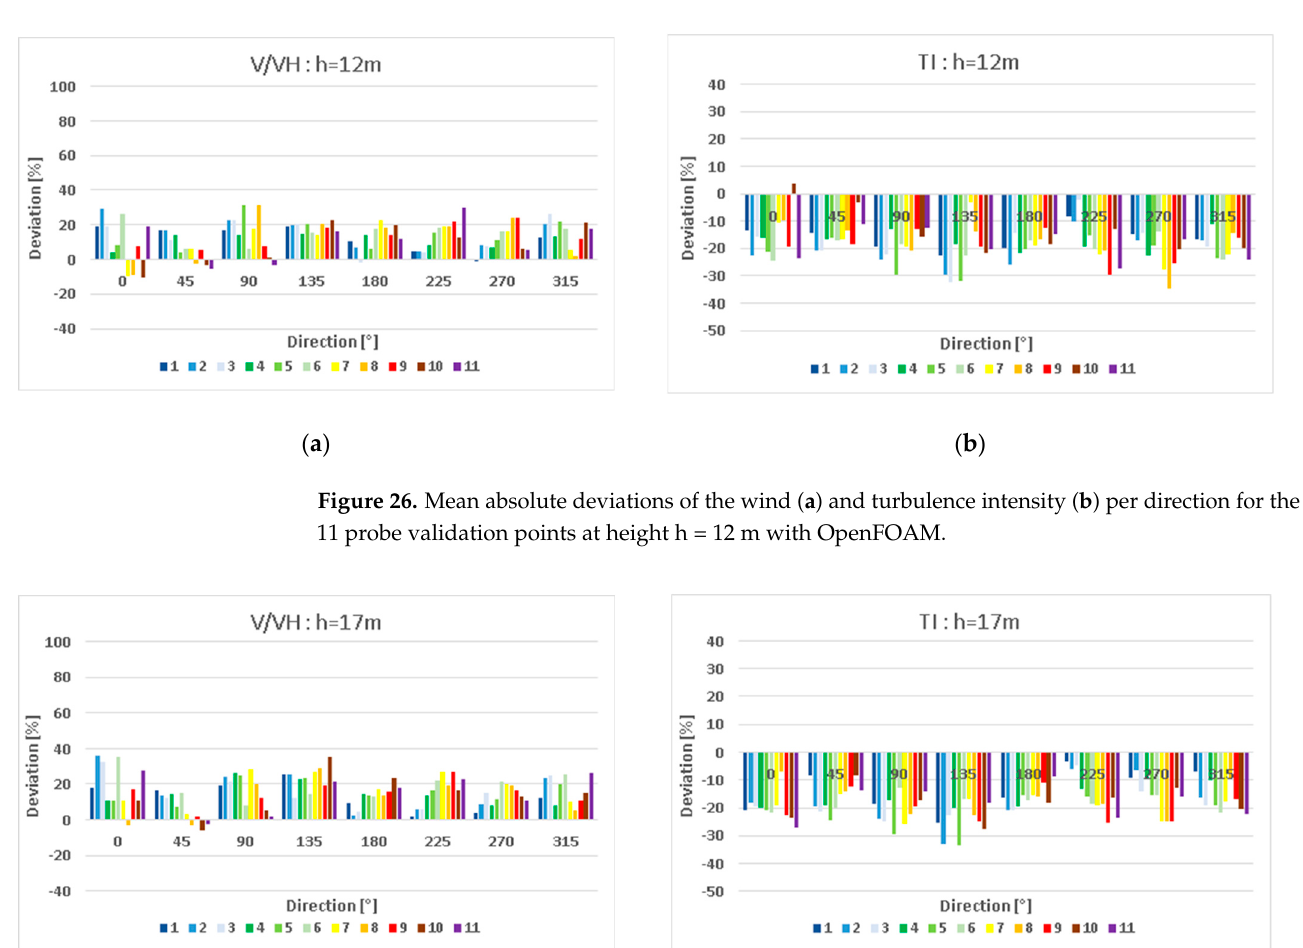
the 11 probe validation points at height h = 9 m with OpenFOAM.